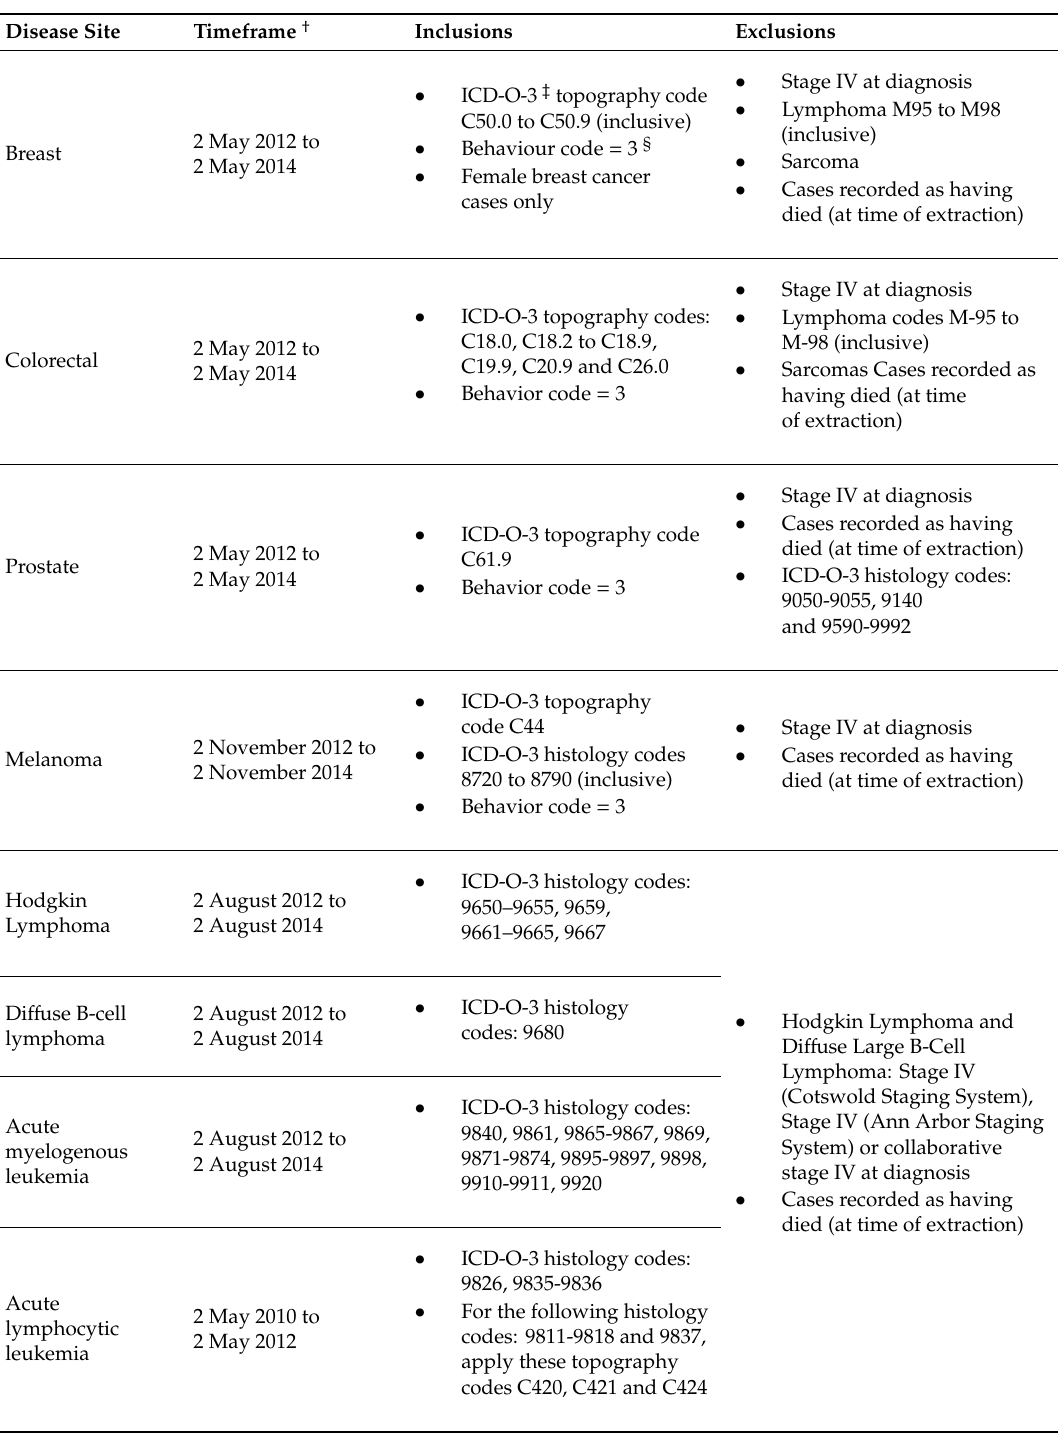
Table 1. Adult cohort: inclusion and exclusion criteria by disease